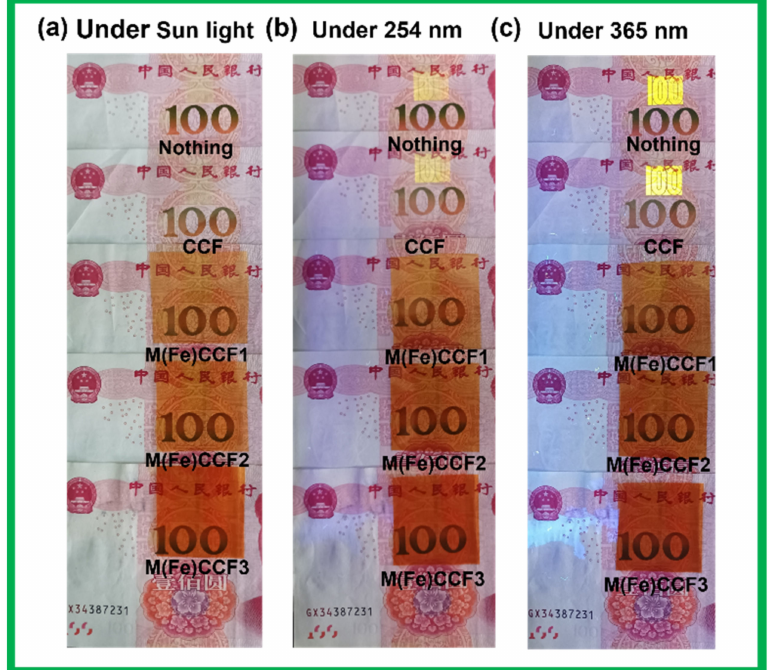
Figure 6. ( a ) Paper money were shielded by nothing, CCF and M(Fe)CCFs and then exposed to sun light. ( b ) Paper money were shielded by nothing, CCF and M(Fe)CCFs and then exposed to UV light (LED, wavenumber of 254 nm); ( c ) Paper money was shielded by nothing, CCF and M(Fe)CCFs and then exposed to UV light (LED, wavenumber of 365